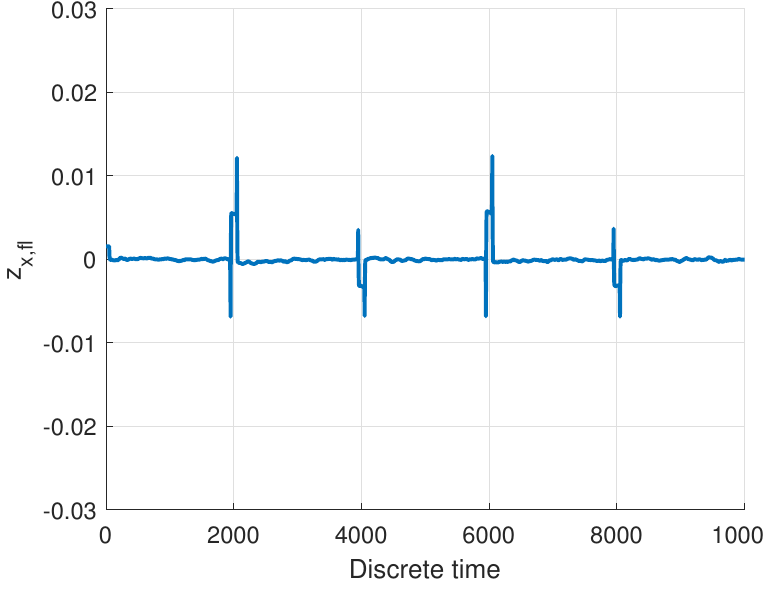
Figure 10. Residual z x , fl for the fault-free case.